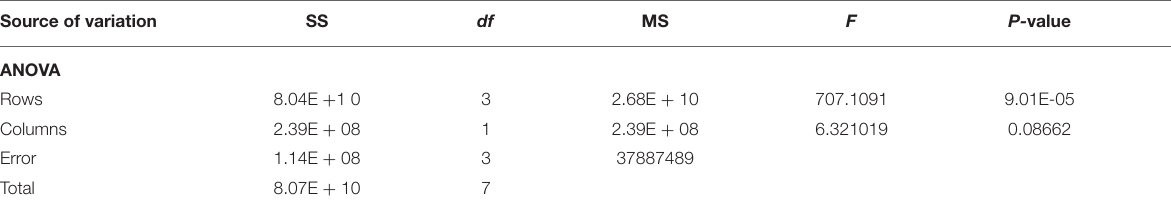
TABLE 15 | Statistical analysis of Kharif season from Table 17 . Source of variation